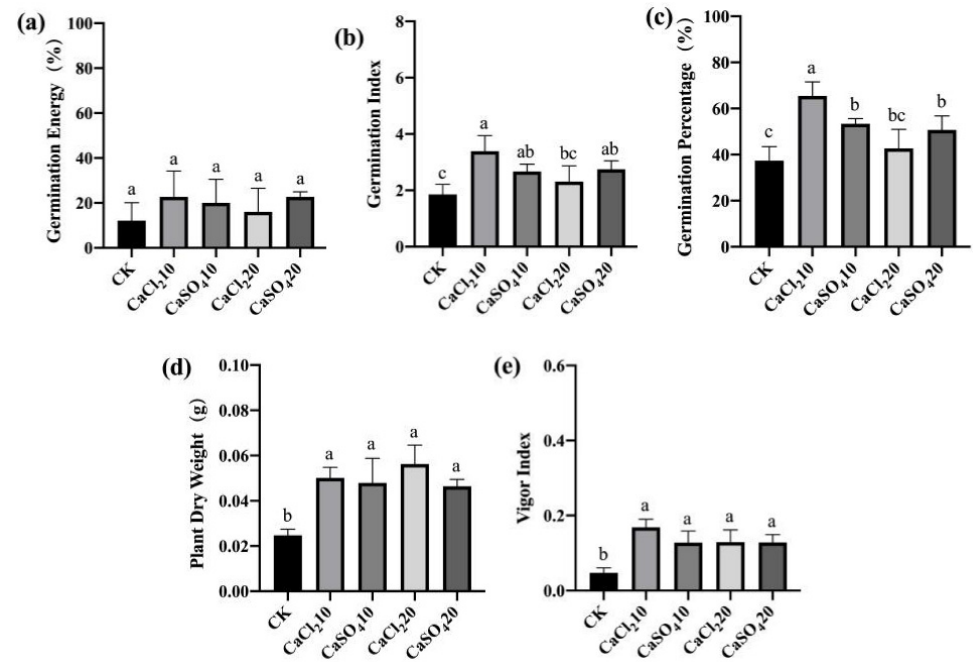
Figure 10. Exogenous Ca 2+ enhanced the resistance of low-vigor maize seeds to F. graminearum . ( a ) germination energy (%), ( b ) germination index, ( c ) germination percentage (%), ( d ) dry weight of single plant (g), ( e ) vigor index. CaCl 2 10/20, 10/20 mmol/L CaCl 2 solution; CaSO 4 10/20, 10/20 mmol/L CaSO 4 solution; CK, control. Different letters indicate significant differences among different lines (Tukey’s test).